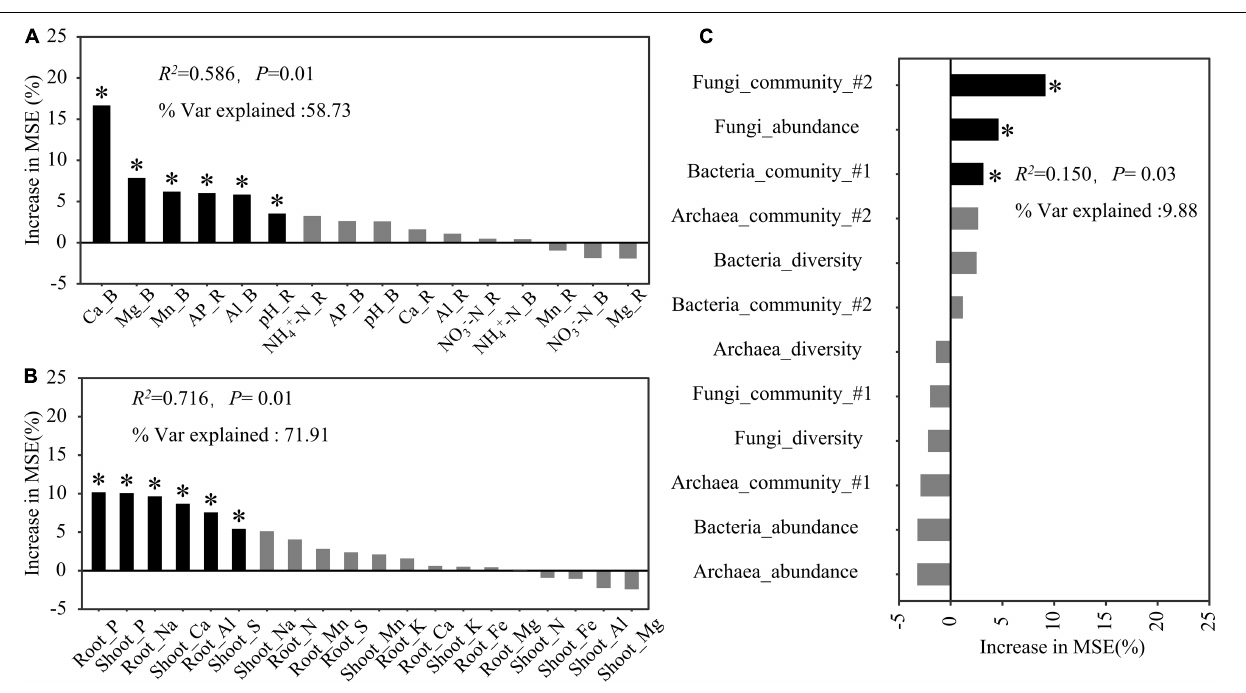
previous studies on soybean (Yang et al., 2012b; Lian et al.,